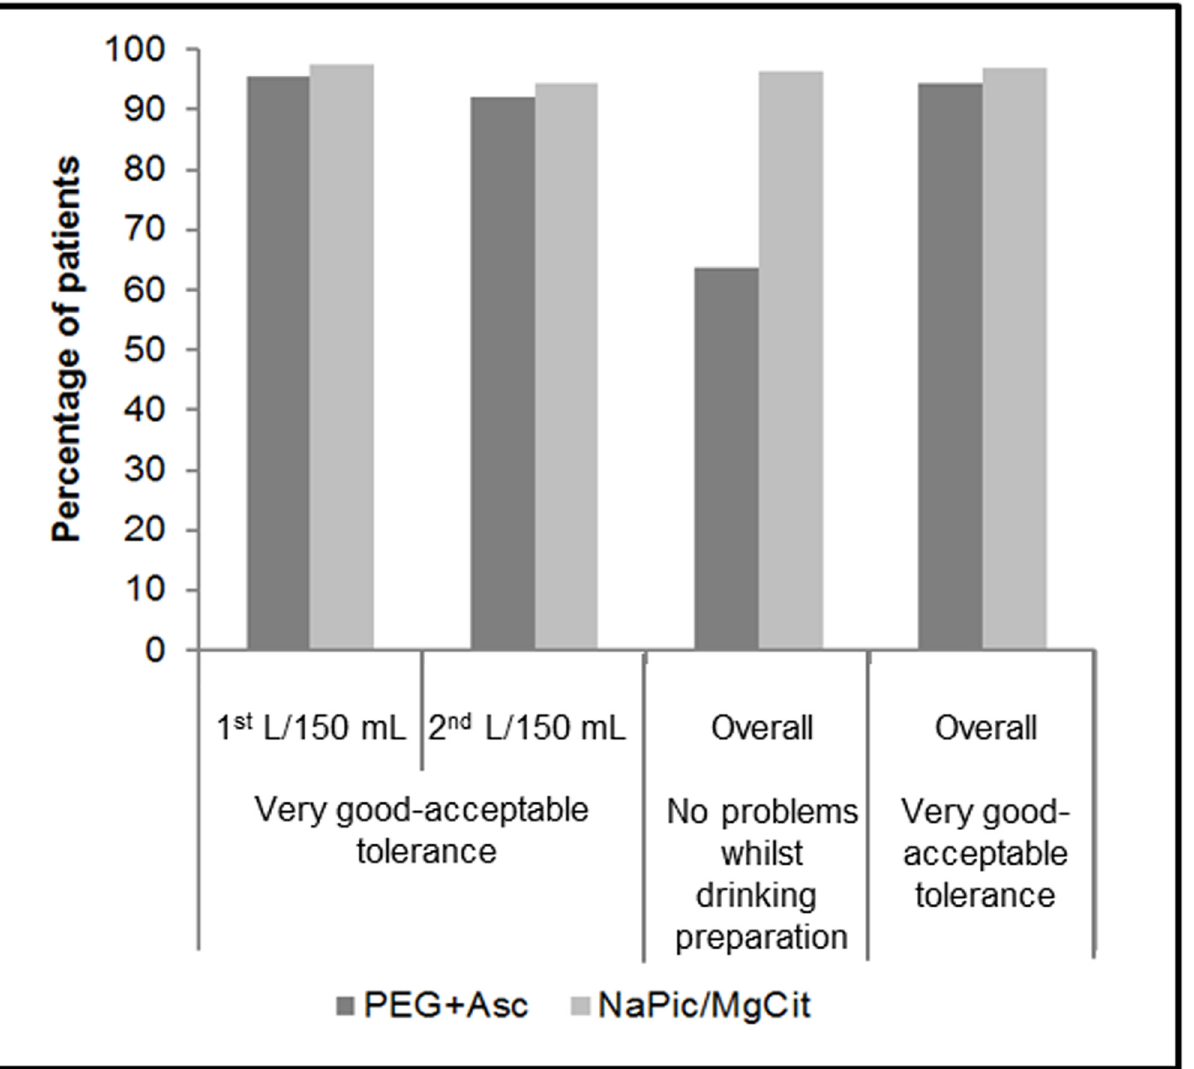
Fig 5. Tolerance of PEG+Asc and NaPic/MgCit assessed by patients via a questionnaire (Safety population). The percentages of patients who reported “ Very good ” , “ Good ” or “ Acceptable ” (Very Good — Acceptable) tolerance are presented for each treatment group together with the percentages of patients who reported that they had no problems while drinking the bowel cleansing solution. NaPic/MgCit, sodium picosulfate/magnesium citrate; PEG+Asc, polyethylene glycol plus